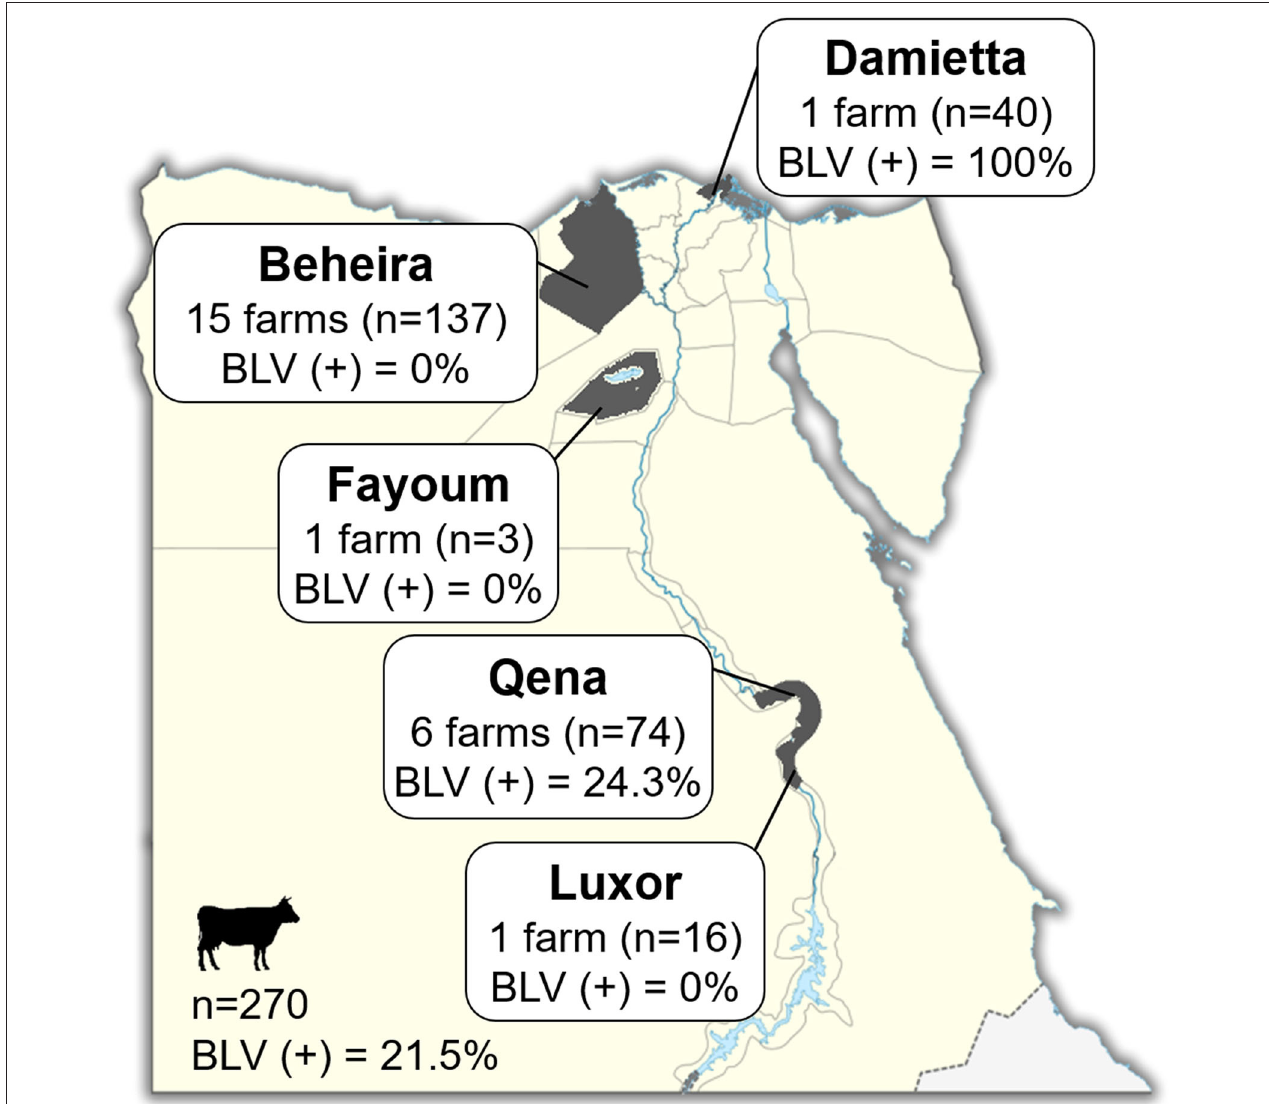
FIGURE 1 | Map of Egypt showing the location of dairy farms for sample collection. Dark gray colored area indicates the geographic location of each region in our study. The number (n; head) of cattle and number (n) of farms in each province and throughout Egypt are indicated in Square. BLV( + ) % indicates the BLV prevalence